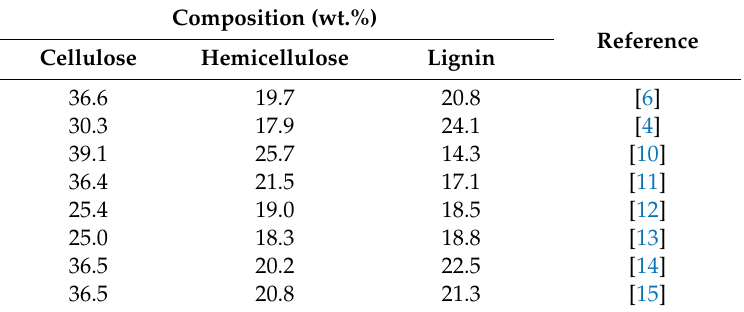
Table 1. Olive-pruning debris fiber composition.